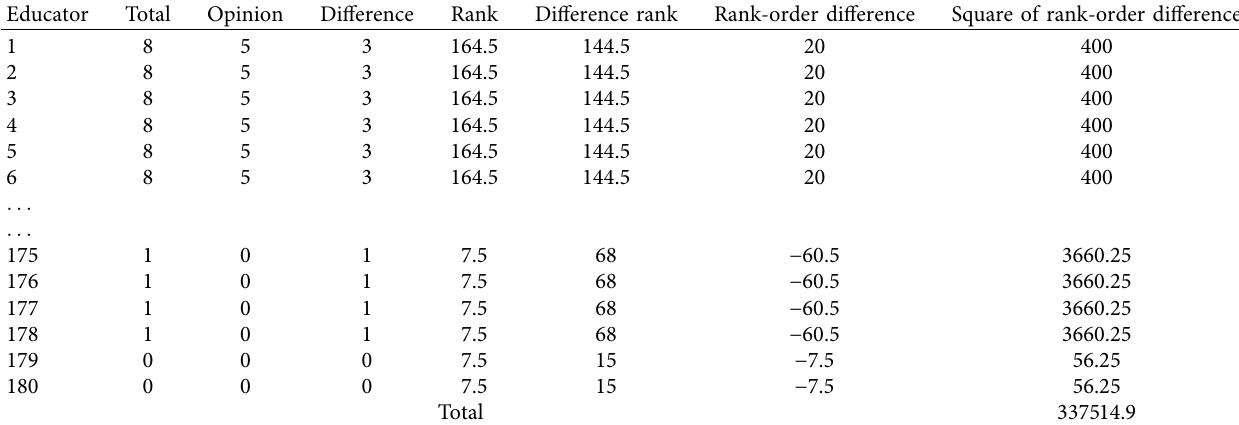
Table 2: Results of calculations by the opinion on the acuteness of the problem of IPR